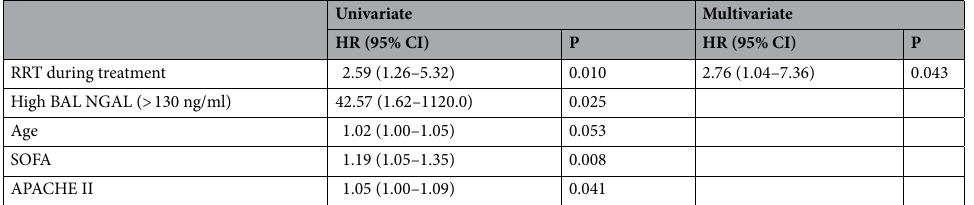
Table 3. Cox proportional hazards regression analysis on BAL NGAL for ICU mortality. HR hazard ratio, CI confidence interval, RRT renal replacement therapy, NGAL neutrophil gelatinase-associated lipocalin, BAL